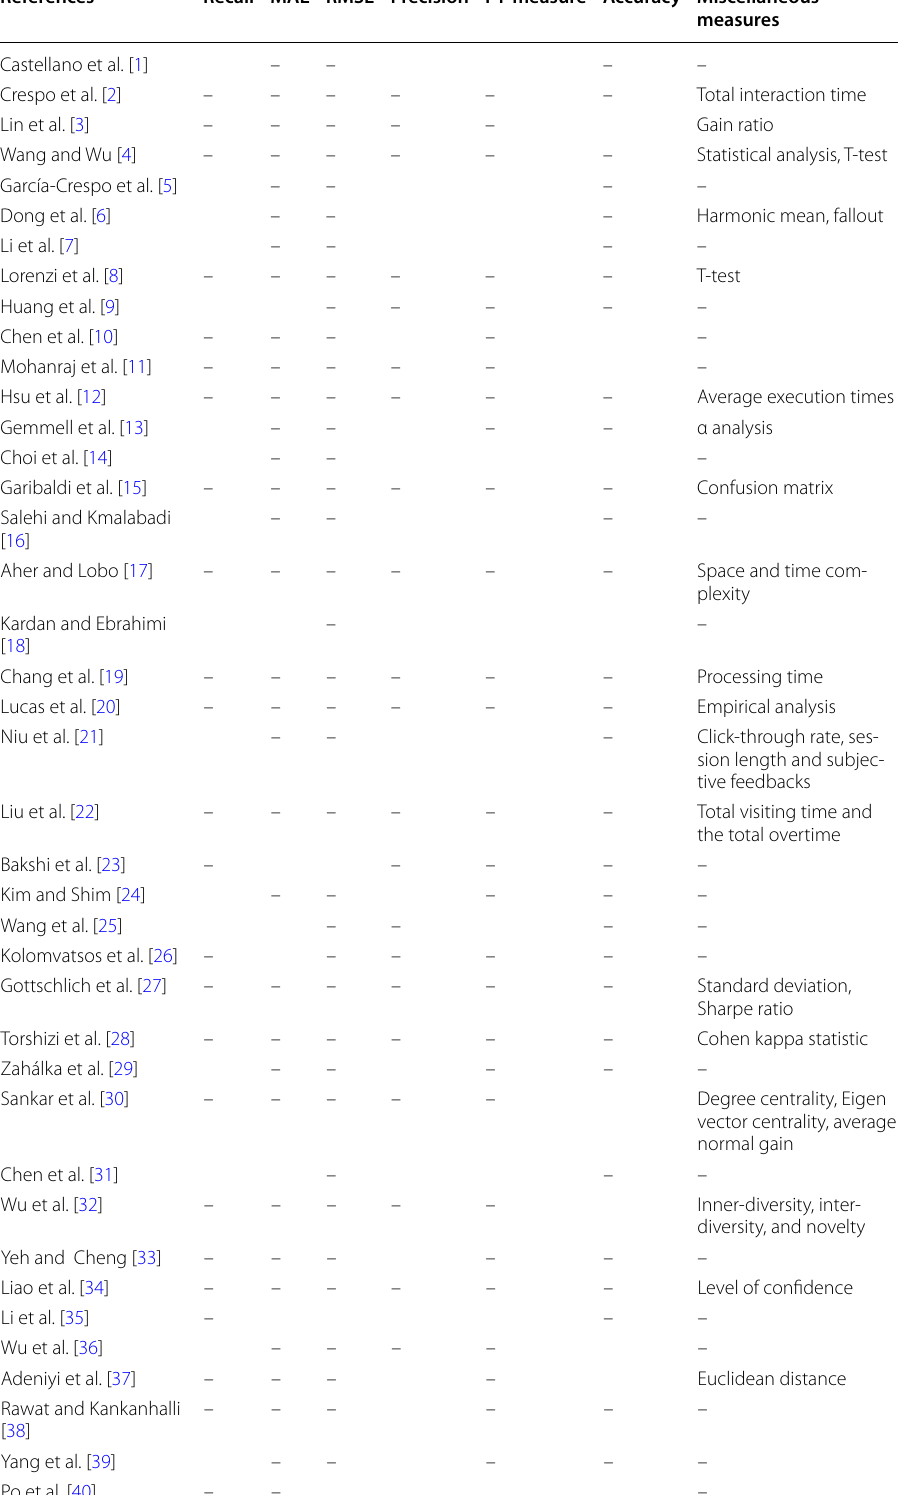
Table 9 Performance analysis of different recommender